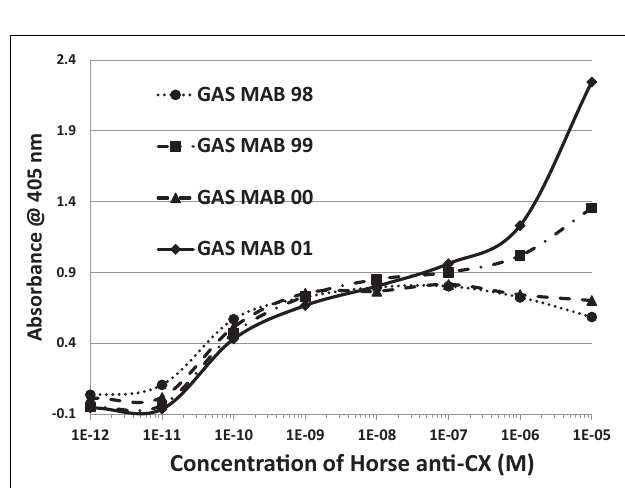
FIGURE 9 | Results of double-antibody ELISA (DA-ELISA) experiments involving monoclonal antibodies against groupA streptococci (GAS MAB) binding to horse anti-coxsackie B4 serum . Binding constants for Table 4 were derived from the inflection points of the curves. Note that two of the antibodies also display a second, low affinity binding to each other at high concentrations of CX antiserum.Very similar results were obtained for group A streptococci (GAS MAB) binding to monkey anti-coxsackie B3 serum (data not